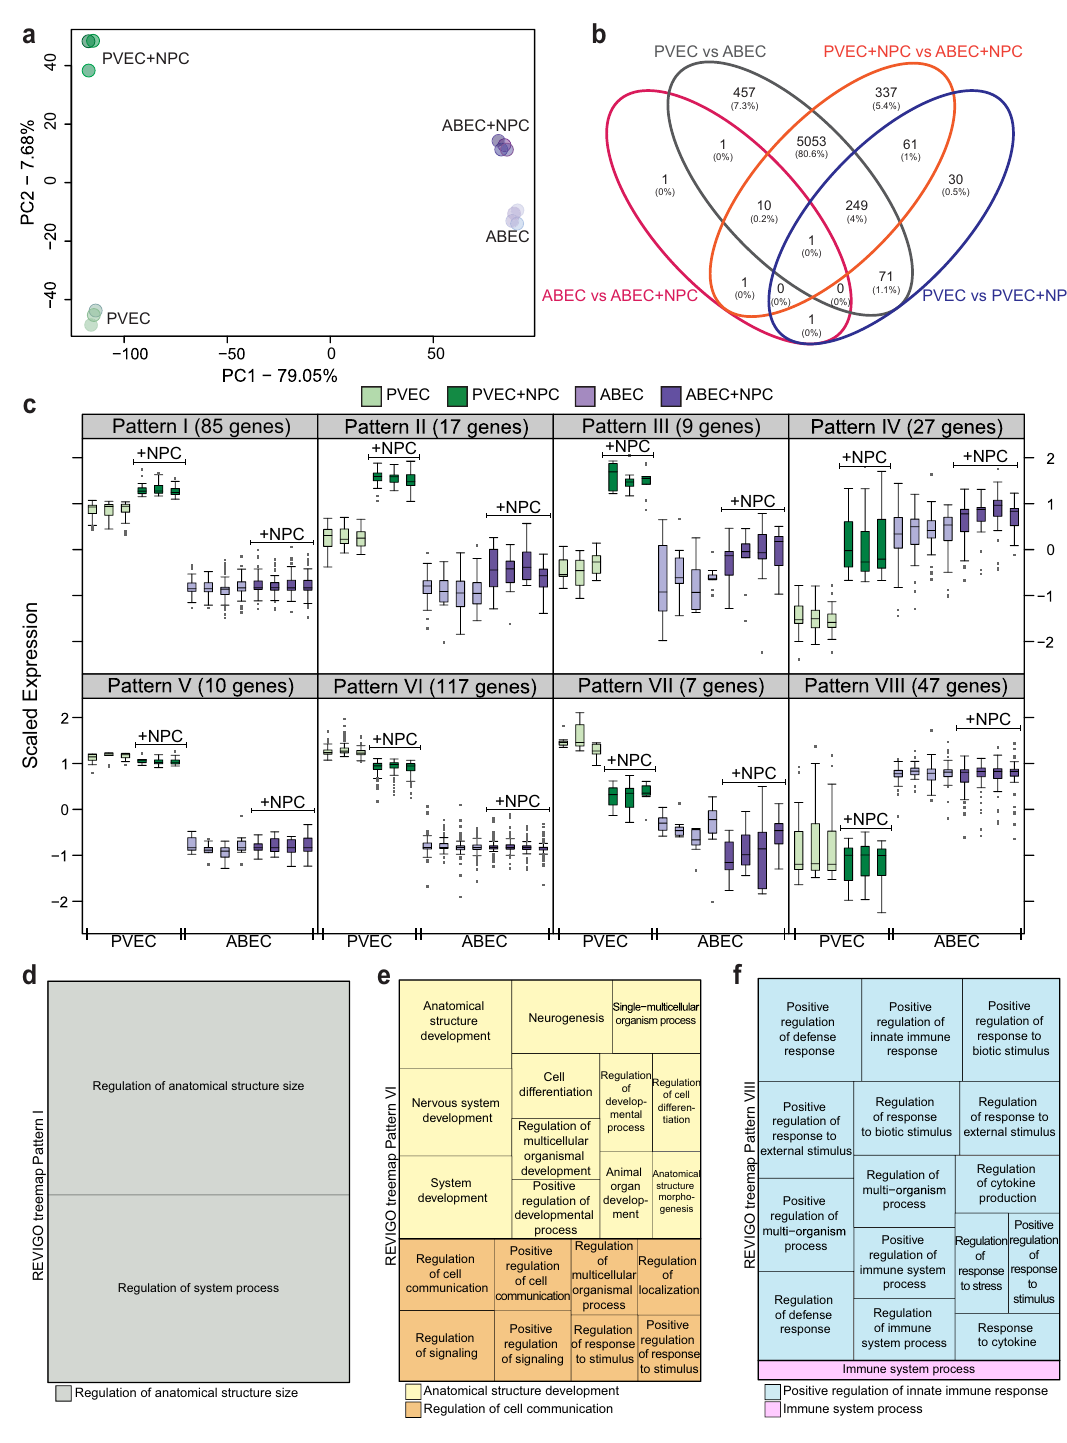
Figure 3. Comparative transcriptomic analysis of PVEC vs. ABEC following co-culture with NPC indicate major changes in PVEC not ABEC. ( a ) Principal component analysis (PCA) of transcriptome. Colors of circles refer to the origin of samples: green PVEC and purple ABEC, light versus dark shades indicate mono vs. NPC co-culture conditions. ( b ) Venn Diagram of DEG in PVEC vs. ABEC (grey ellipse), PVEC + NPC vs. ABEC + NPC (orange ellipse), ABEC vs. ABEC + NPC (pink ellipse) and PVEC vs. PVEC + NPC (blue ellipse). ( c ) Eight different self-organizing maps (SOM) patterns of gene expression profiles were identified amongst the 321 genes that were different in PVEC vs. PVEC + NPC and also in PVEC vs. ABEC. The upper panels display patterns whose gene expression is upregulated in PVEC + NPC as compared to baseline PVEC. Data is shown as standard boxplots (box and whisker plots), depicting the median bar and the dots representing the outliers. Lower panels depict patterns whose gene expression is downregulated in PVEC + NPC as compared to baseline PVEC. Treemap representation of GO_bp (biological process) using REVIGO (reduced visualization of GO) corresponding to ( d ) Pattern I, ( e ) Pattern VI and ( f ) Pattern